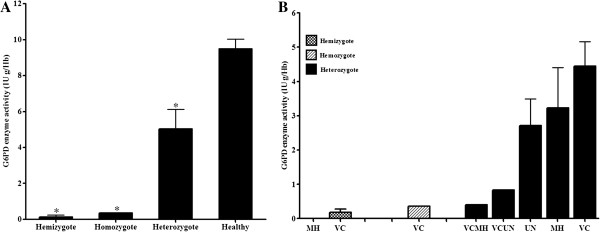
The means and standard errors of G6PD activity in (A) Red blood cells of G6PD normal, hemizygous, homozygous, and heterozygous G6PD-deficienct subjects (B) G6PD activity stratified by genotype; MH = Mahidol, VC = Viangchan, VCMH = Viangchan-Mahidol, VCUN = Viangchan-Union, UN = Union (all groups were significantly different *P < 0.001).